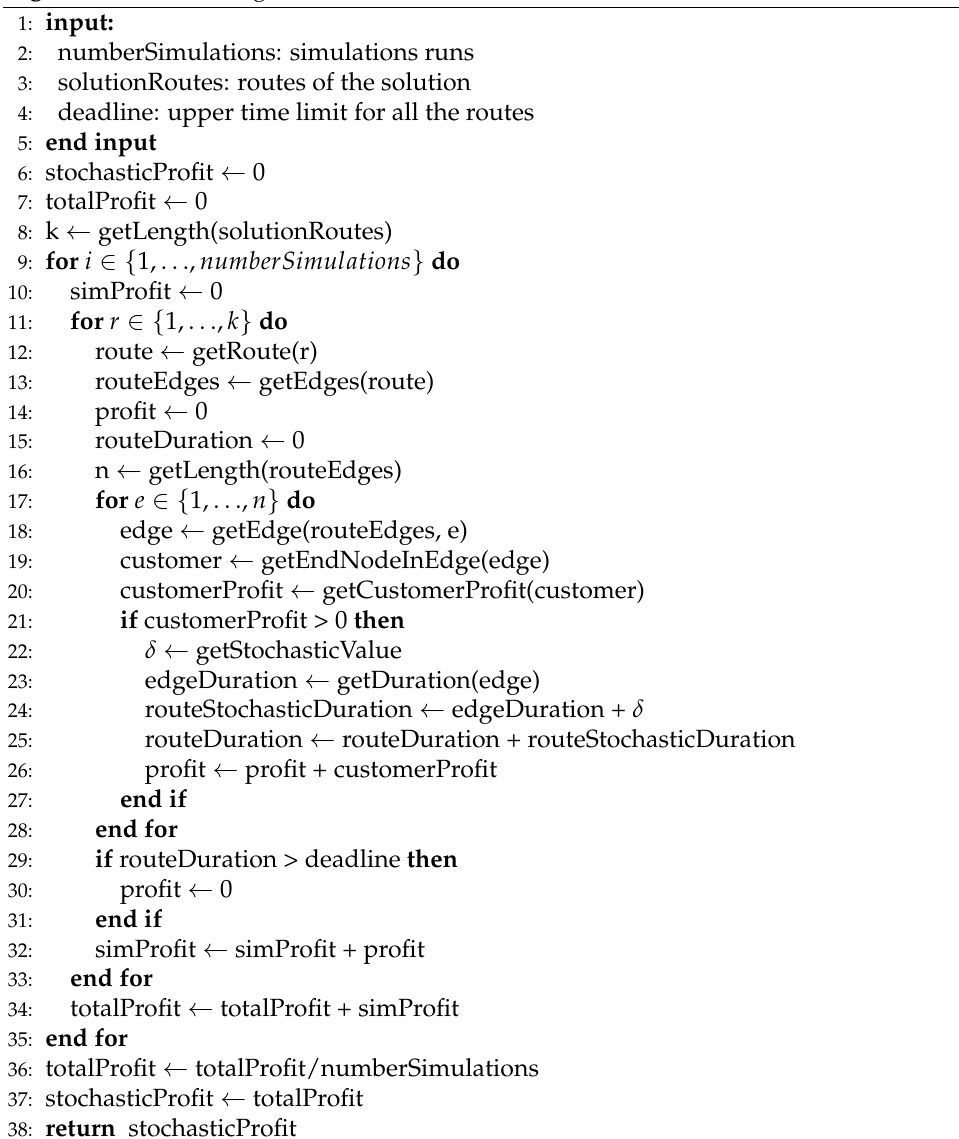
Algorithm 2 Simulating a